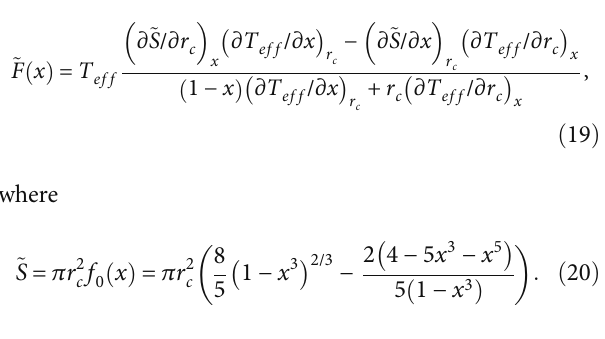
= ð 1 + x + x 2 Þ / c = 0 : 03 , solid green line +